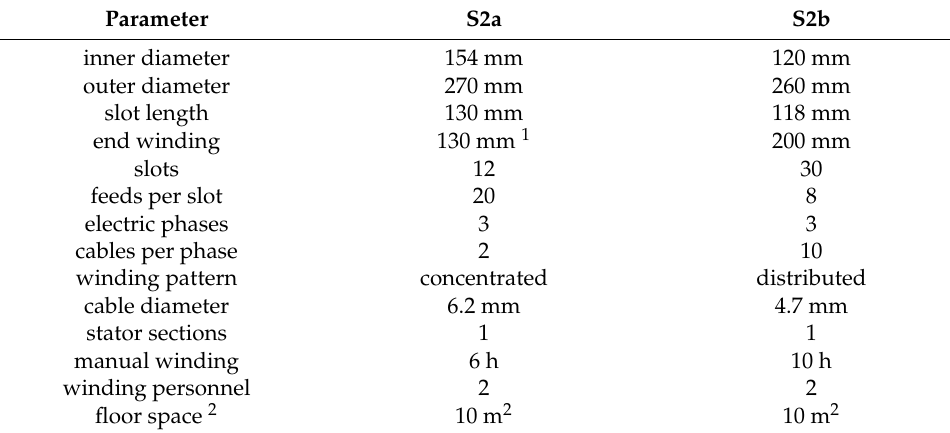
Figure 3. The electric vehicle propulsion motors developed at UU and used as examples of smaller rotating cable wound electric machine in this paper: The vehicle propulsion motor S2a ( left ), photo from [45], and the vehicle propulsion motor S2b ( right ). Table 2. Geometric and winding characteristics for S2a-b.